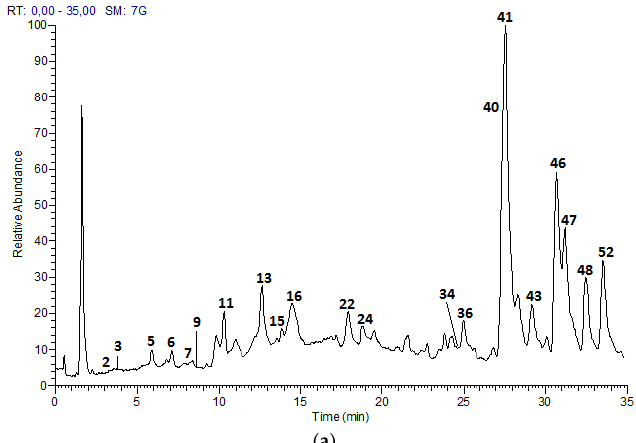
( a ) Figure 2. Cont